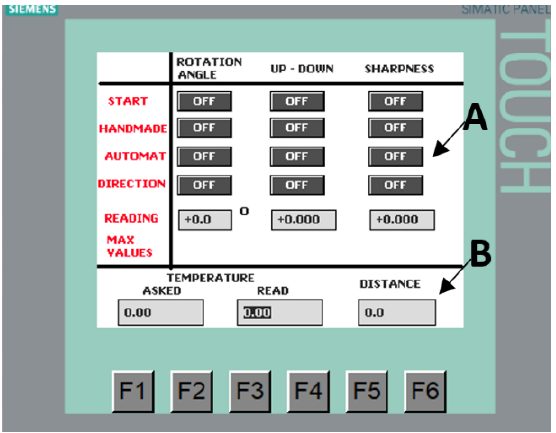
Figure 2. View of the touch panel window; A — area for controlling stepper motors; B — area of measurement fields.